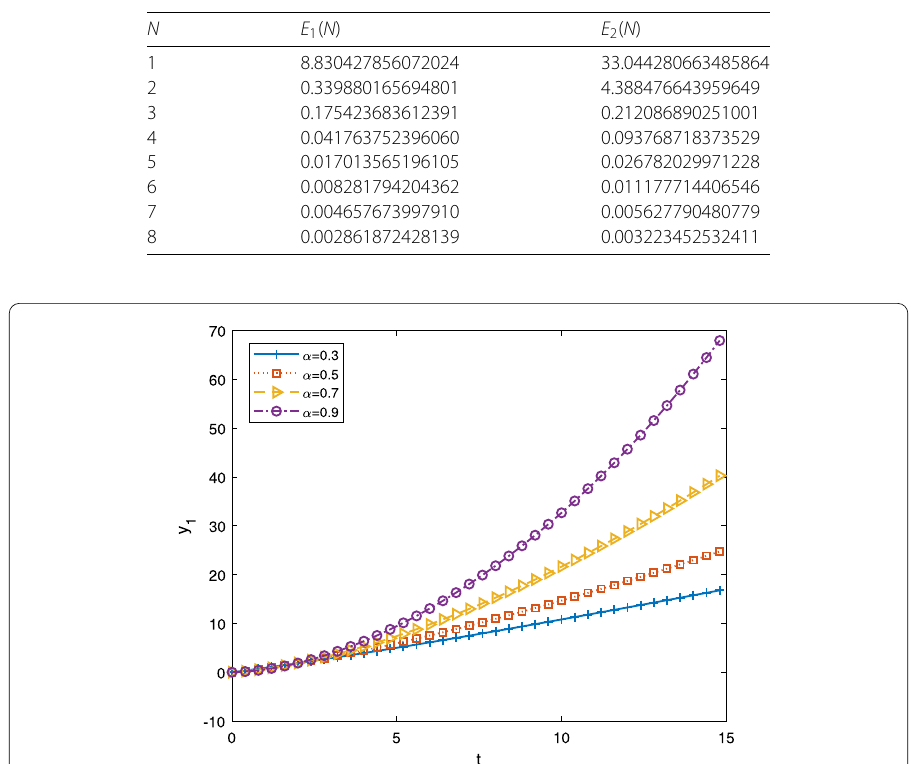
Figure 3 Numerical solution of Example 8.3 for the first component with N = 10